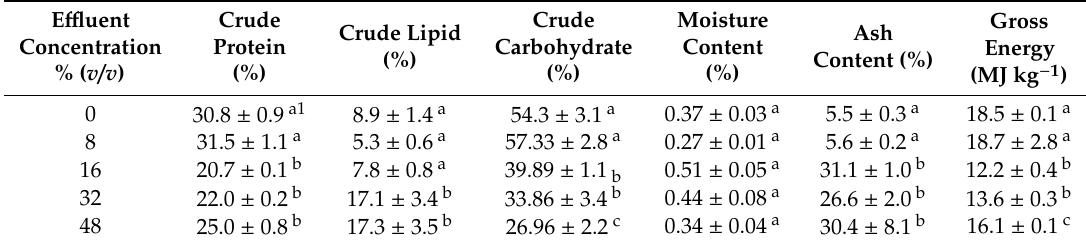
Table 1. Proximate composition of dried algal biomass of S. limacinum grown on medium containing effluent digestate at varying concentrations (0–48%) at the same carbon and nitrogen concentration without the addition of micronutrients.